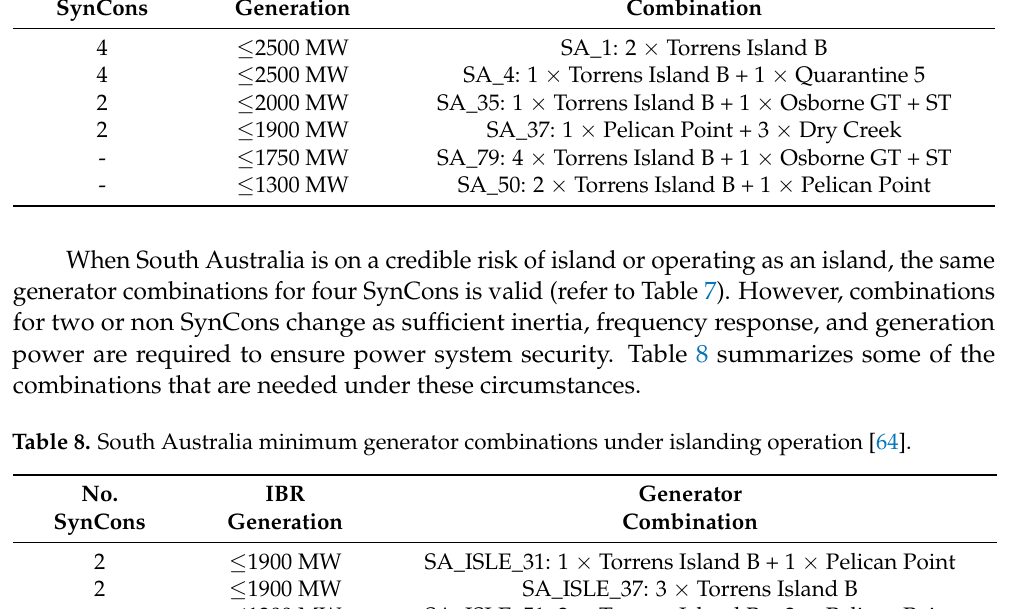
Figure 6. Simplified diagram of the South Australian grid. Table 7. South Australia minimum generator combinations under system normal operation [64]. No.